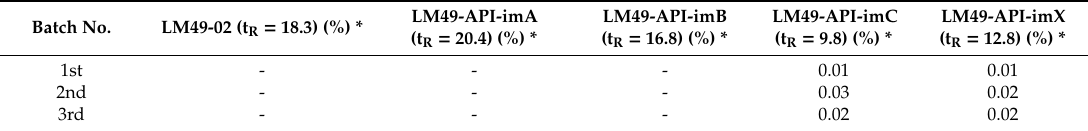
Table 12. The impurity profile of three batches for LM49-API .